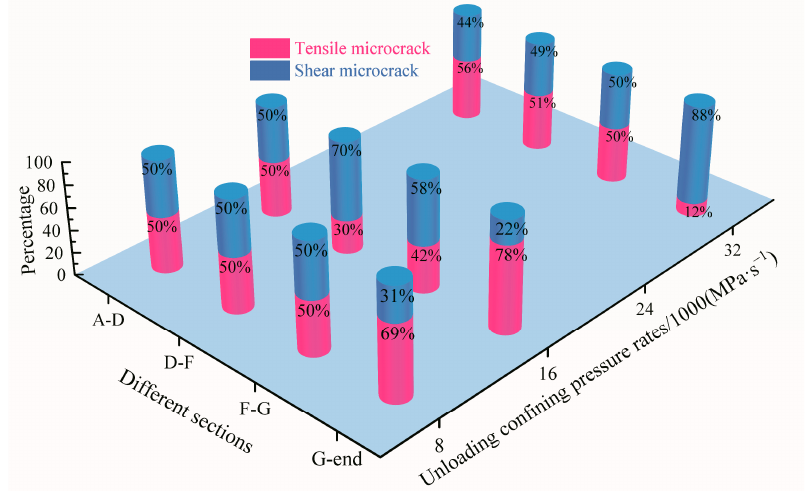
Figure 13. Percentage of tensile and shear microcracks in different damage sections of diorite under different unloading confining-pressure rates.